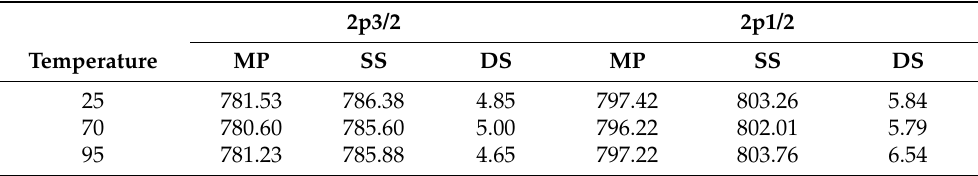
Figure 4. High-resolution XPS spectrum for SiO 2 /Co(OH) 2 synthesized at room temperature (25 °C). Table 1. XPS binding energies (eV) for Co at different synthesis temperatures for Cab-O-Sil-based SiO 2 /Co(OH) 2 nanocomposite catalysts